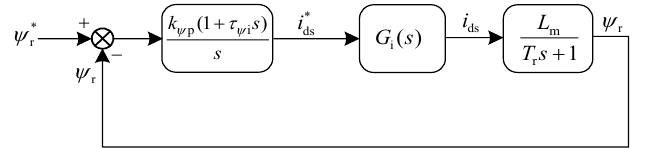
Figure 11. The control diagram of the flux loop.